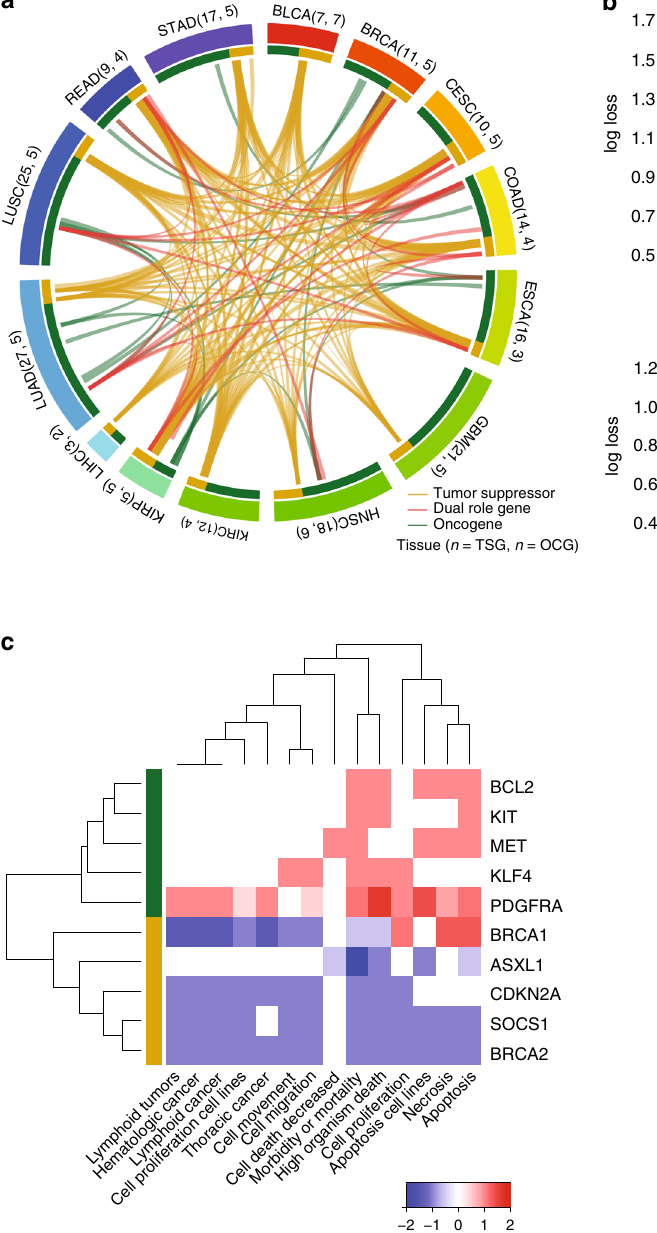
Fig. 7c; Supplementary Data 13). For example, Moonlight identi fi ed H2AF as a highly expressed oncogene in several breast-cancer cell lines. In contrast, Moonlight identi fi ed SOX7, CYP26B1, DACT2 as tumor suppressors with low expression in these same cell lines. These fi ndings were also supported by literature 22,73 – 75 .